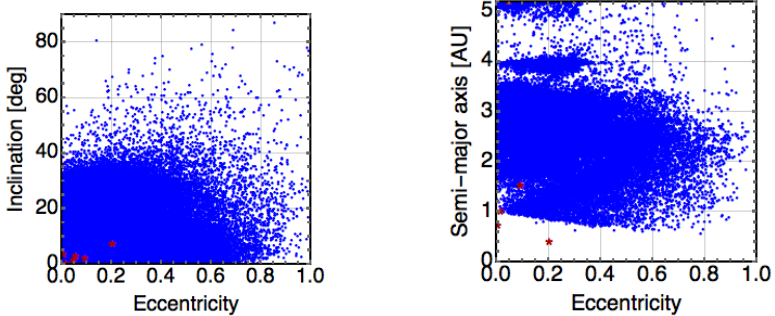
Figure 1. This figure represents the distribution of the orbital parameters for the Solar System Objects (SSOs) expected to be observed by the Gaia satellite. The red stars represent the innermost planets of the Solar System.